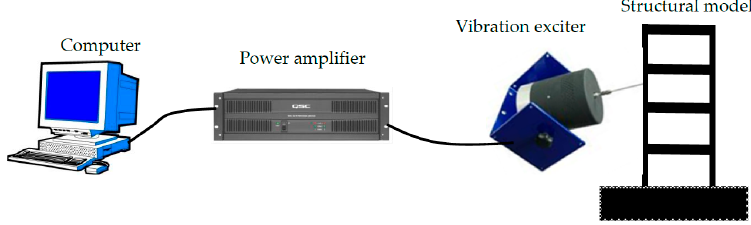
Figure 10. Experiment setup.